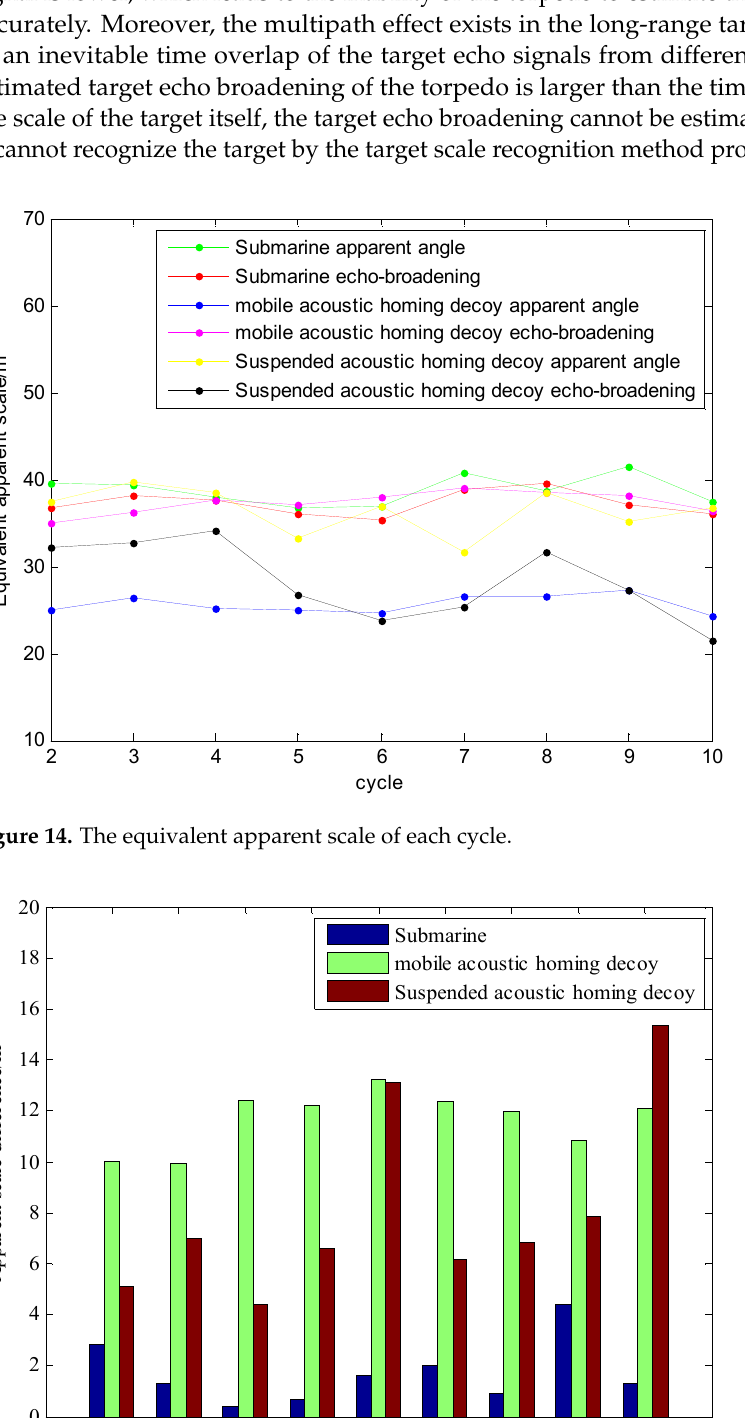
Figure 13. The target echo signal parameter estimation process. ( a ) The time domain echo signal. ( b ) The azimuth pre-beamforming. ( c ) The target orientation. ( d ) The time domain signal after correla- tion.